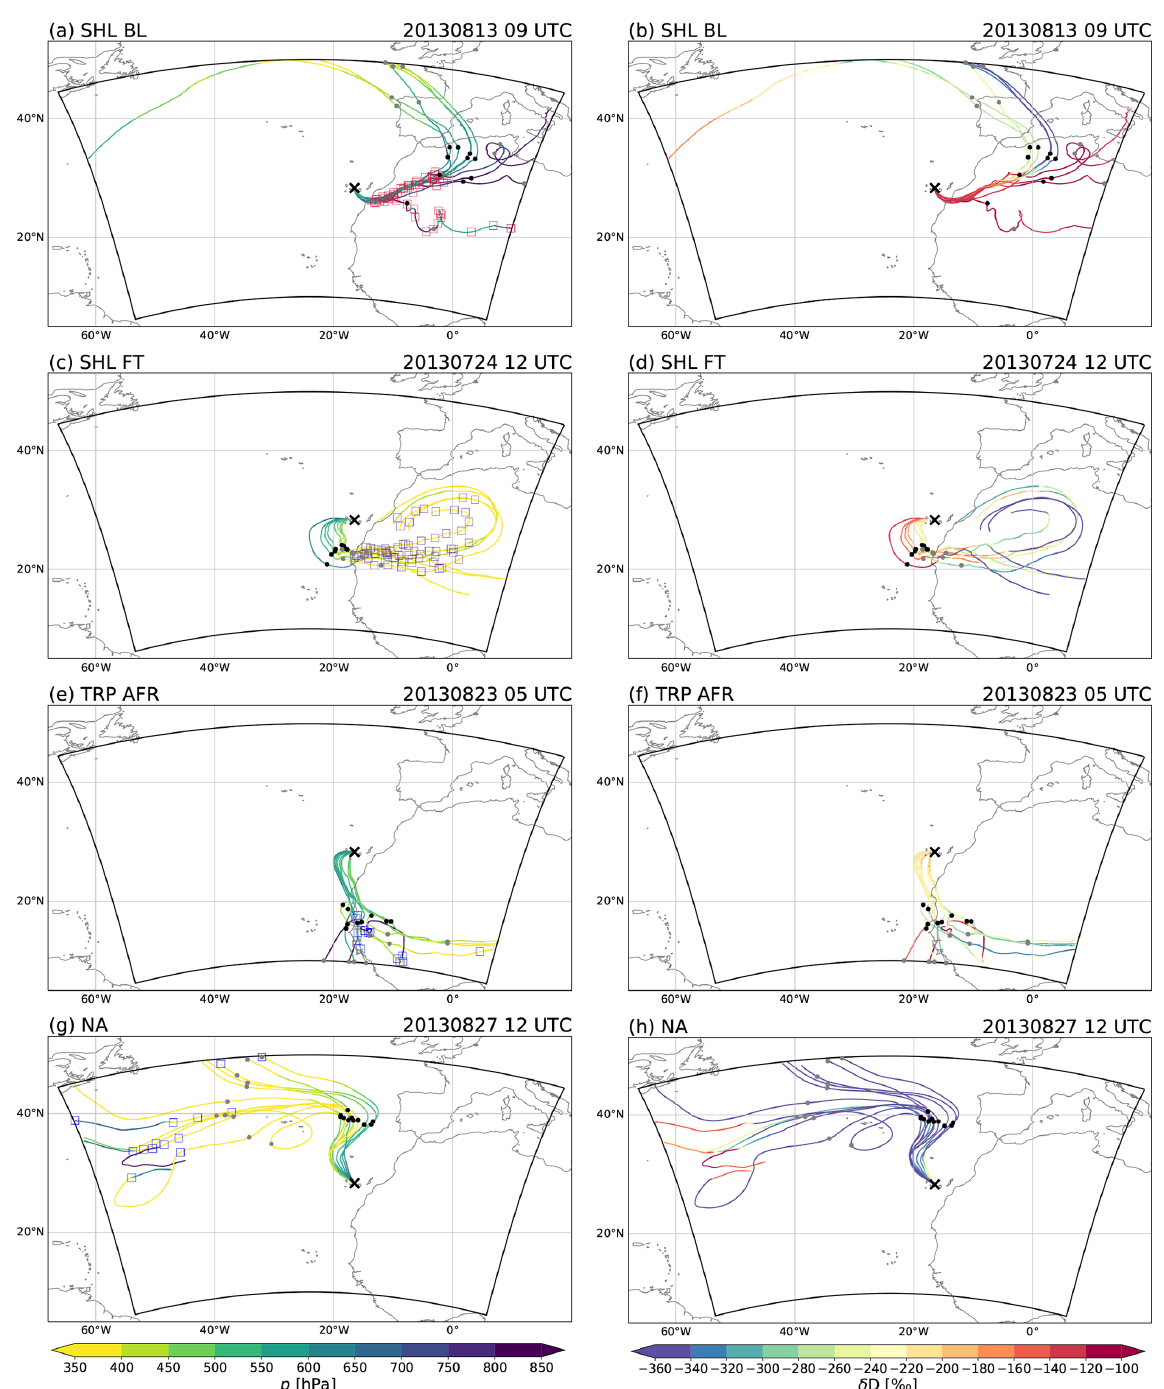
Figure 10. COSMO iso 10d backward trajectories showing typical transport pathways of (a, b) air parcels originating from the boundary layer of the Saharan heat low (SHL BL), (c, d) air parcels coming from the free troposphere above the Saharan heat low (SHL FT), (e, f) air parcels originating from tropical Africa (TRP AFR), and (g, h) air parcels coming from the North Atlantic (NA). The trajectories are coloured according to their pressure p (left column) and δ D signal (right column). The black cross depicts the starting position above Tenerife and the black and grey dots the trajectory positions 3 and 5d backward in time. Red squares in (a) indicate that a trajectory was in the boundary layer of the Saharan heat low at the respective time and location, purple squares in (c) show that a trajectory was in the free troposphere above the Saharan heat low, and blue squares in (e, g) mark the occurrence of surface precipitation. The time expression in the title indicates the starting time of the backward